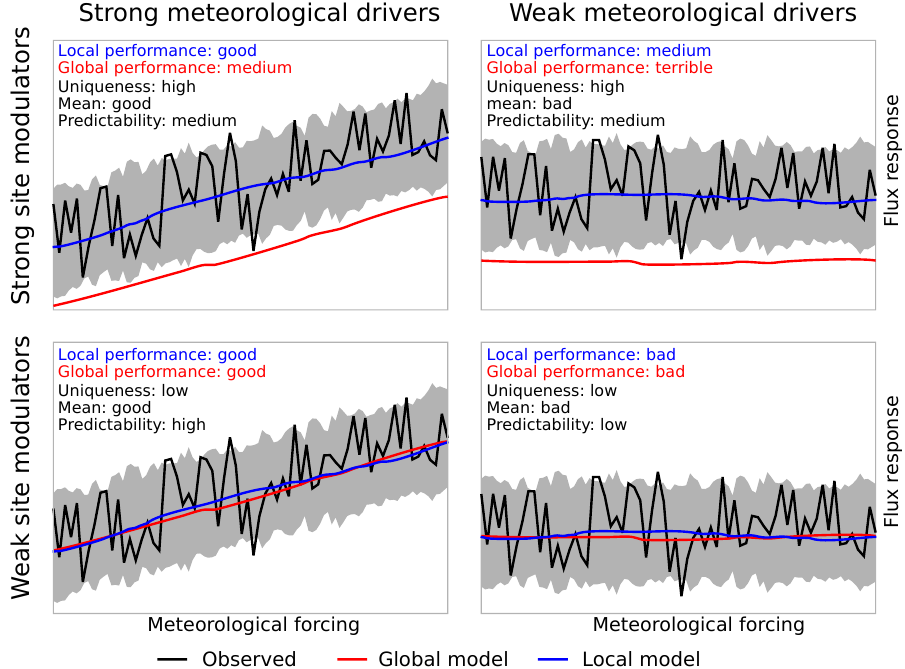
Figure 11. Schematic of sources of variability and how they affect predictability, mean performance, and uniqueness. The black line and grey ribbon represent the flux observations and the unpredictable internal variability or noise in the system. “Meteorological drivers” indicate universal physical relationships between meteorological forcings and fluxes; here we have indicated this using a simple linear trend as an example. “Site modulators” are characteristics of the site (soil or vegetation properties, storage pools, geography, or data problems) that modulate the meteorological–flux relationship such that it is different to the relationships observed globally; here we have used a simple bias as an